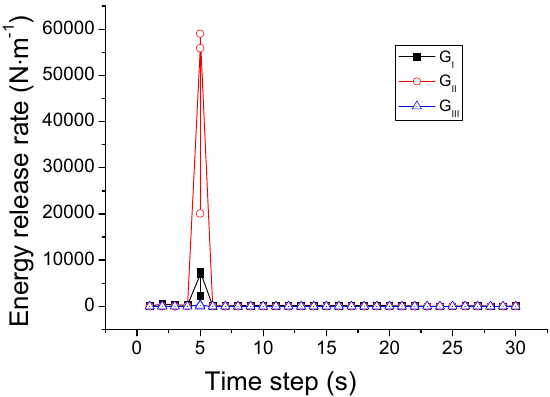
Figure 15. Variation of energy release rates associated with the mixed-mode criterion based on energy release rates.